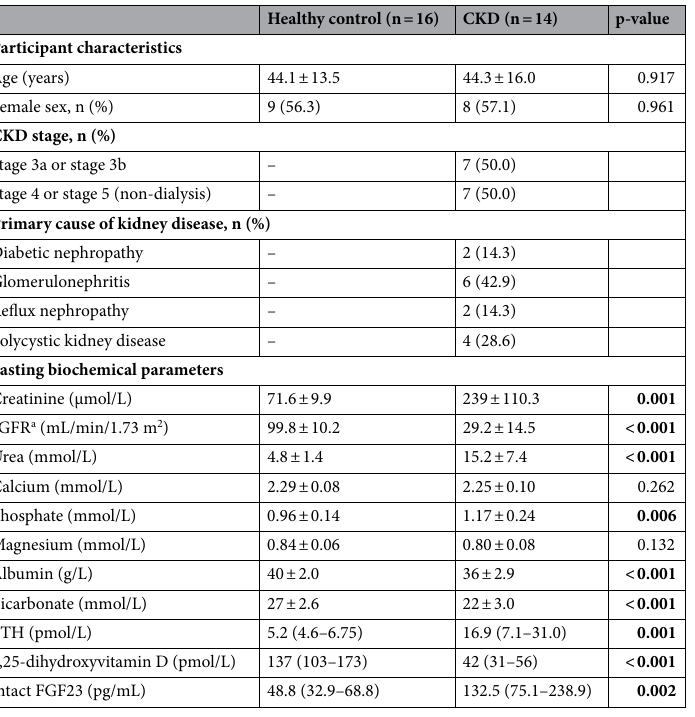
Table 2. Participant demographics and clinical characteristics. P-value is for between group difference, examined using unpaired t-test or Kruskal–Wallis test for normal and skewed continuous variables respectively, and chi-squared test for categorical variables. Mean ± SD, number (percentage) or median (interquartile range). CKD chronic kidney disease, eGFR estimated glomerular filtration rate, FGF23 fibroblast growth factor-23, PTH intact parathyroid hormone. a eGFR—calculated using CKD—Epidemiology Collaboration